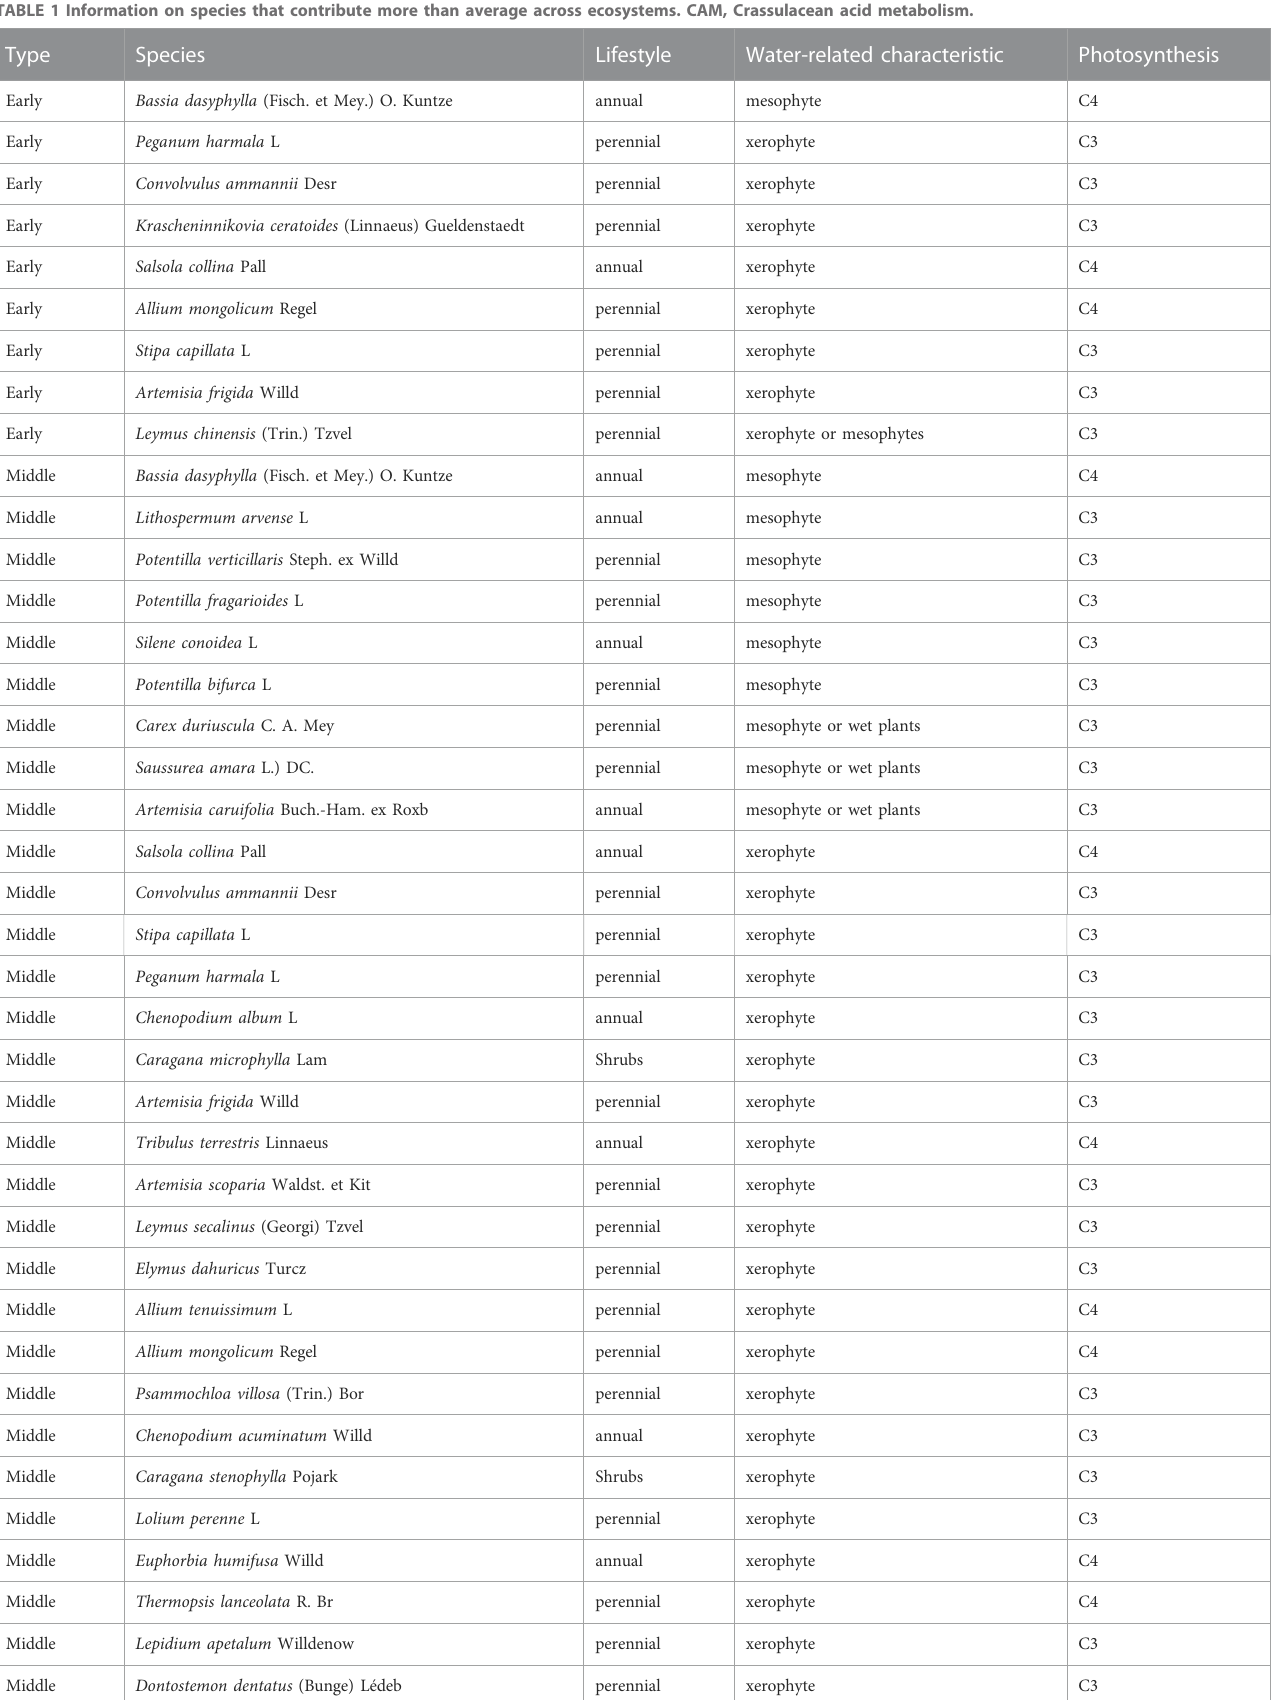
TABLE 1 Information on species that contribute more than average across ecosystems. CAM, Crassulacean acid metabolism. Type Species Lifestyle Water-related characteristic